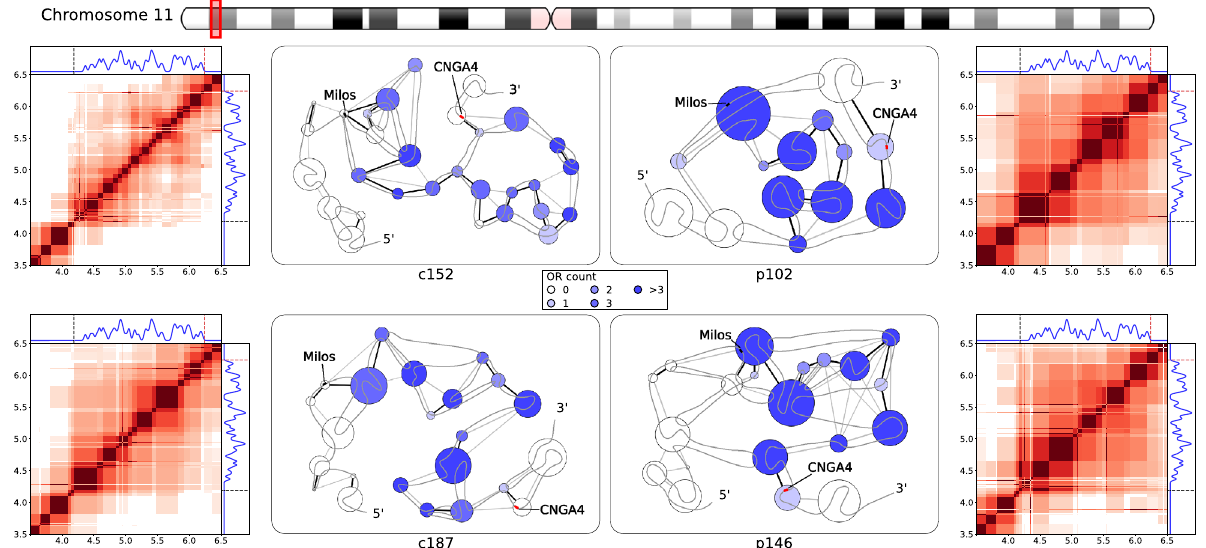
Figure 4. Fine structural organization in the Class I olfactory receptor gene cluster on chromosome 11. Left and right columns. Heatmaps of interactions between structural units in the region 3.5–6.5 Mb of chromosome 11. In the heatmaps, dark red squares along the diagonal mark the size and position of continuous structural units, and off-diagonal colored regions indicate strongly-interacting unit pairs ( r > 0.05 ). The adjoining panels (above and to the right of the heatmaps) show the 1D distribution of Class I olfactory receptor genes (blue trace), putative enhancers mapped from mouse annotations (black dashed lines), and human mature OSN marker genes (red dashed line). The heatmaps for control samples c152 and c187 are shown on the left column, while patient samples p102 and p146 are shown on the right column. Center. Network representations of chromatin structure in the same region 3.5–6.5 Mb of chromosome 11, including the PE Milos and the OSN marker CNGA4. Structural units are represented as circles of radii scaling with unit sizes, colored by the number of ORs in the unit. Black/grey edges connecting the units indicate strong interactions, with black edges indicating an interaction energy ratio r > 0.5 and grey edges indicate 0.2 < r ≤ 0.5. A black trace is overlaid on the network to show genomic positions of the units in the 5’-to-3’ direction on the positive strand. The approximate genomic locations of the PE Milos and the OSN marker CNGA4 are represented by black and red marks